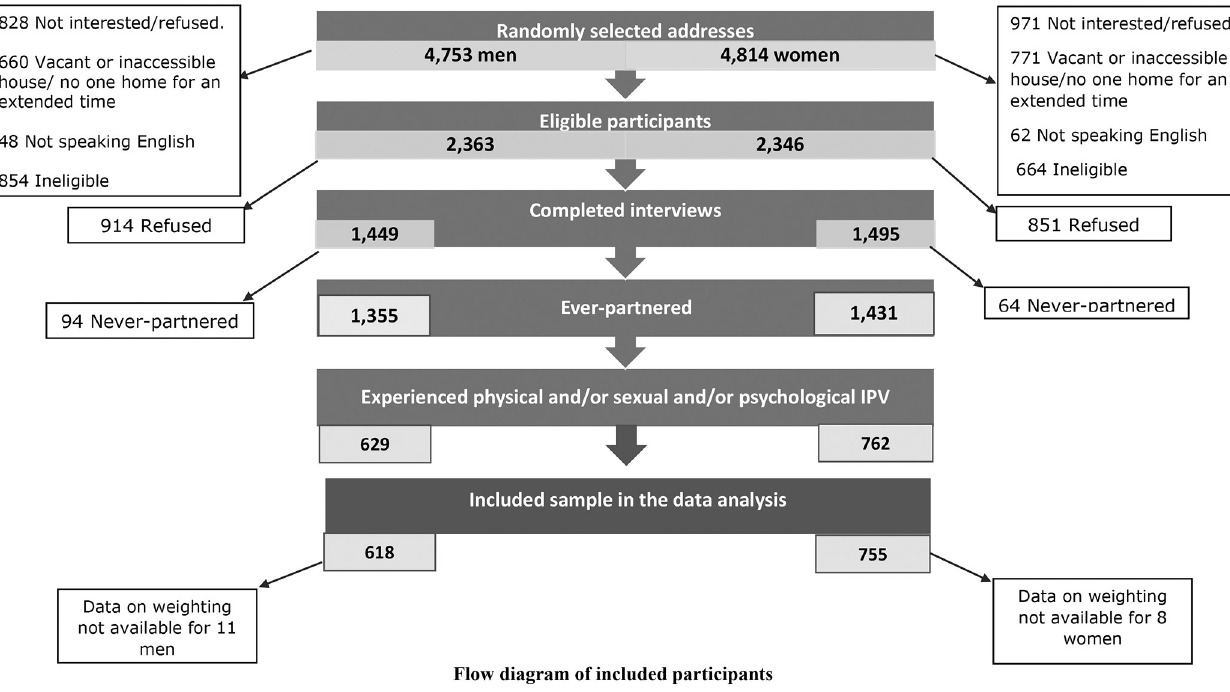
Fig 1. Flowchart showing identification and recruitment steps for included